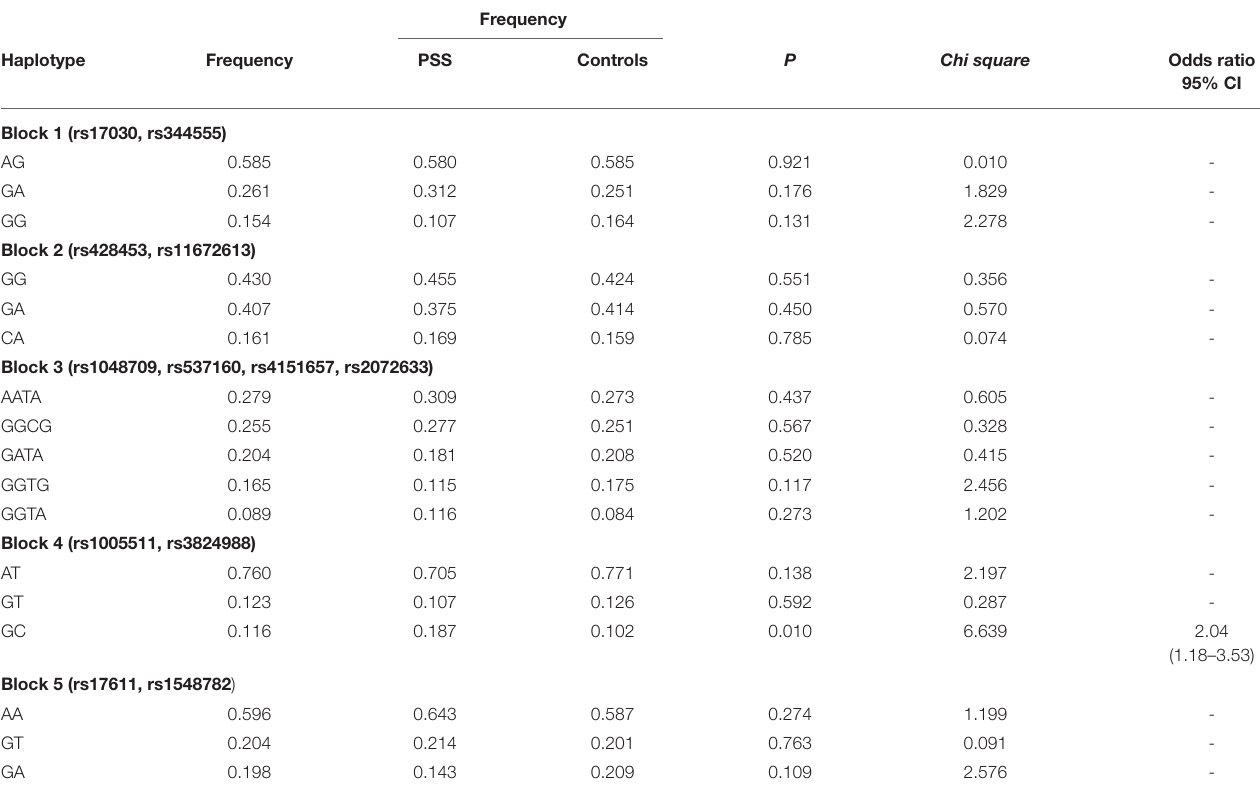
TABLE 6 | Haplotype analysis of complement pathway genes in PSS patients and healthy controls. Frequency Haplotype Controls P Chi